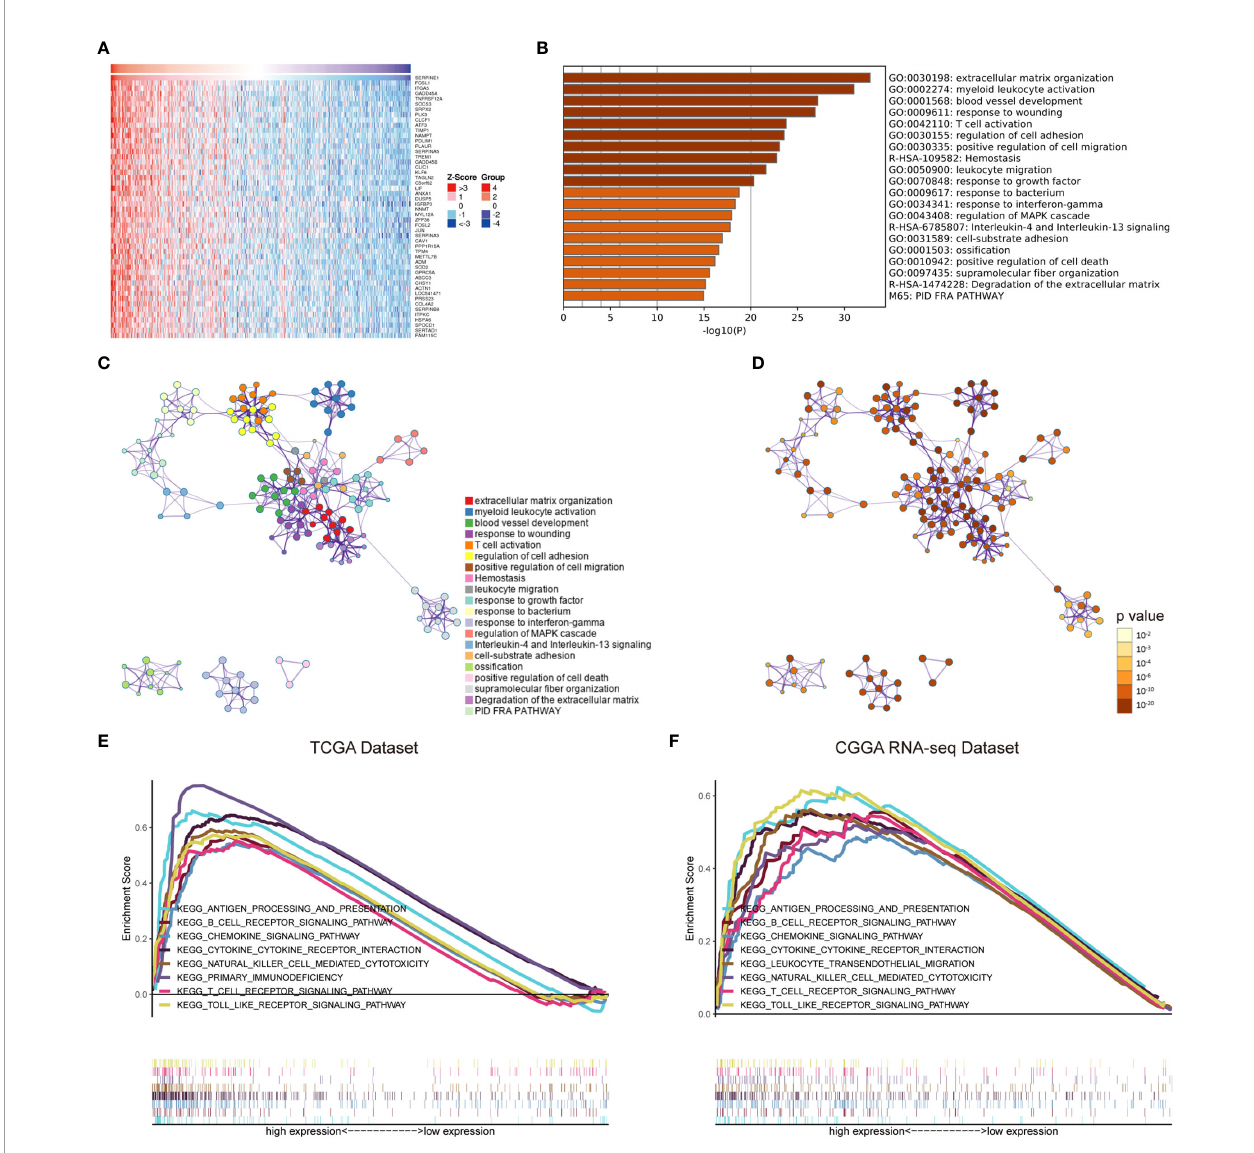
FIGURE 6 | The potential functions of SERPINE1. (A) Heatmap of SERPINE1 positively correlated genes. (B) Bar graph showing the top 20 enriched terms of SERPINE1 positively correlated genes. The color depth denoted the p-value. Network plot of enriched terms: (C) each node represented one enriched term colored by its cluster ID; (D) colored by p-value. GSEA enrichment analysis of SERPINE1 in LGG datasets: (E) the KEGG pathways enriched in high SERPINE1 expression group of TCGA dataset; (F) CGGA dataset. P-value < 0.05 was considered statistically signi fi